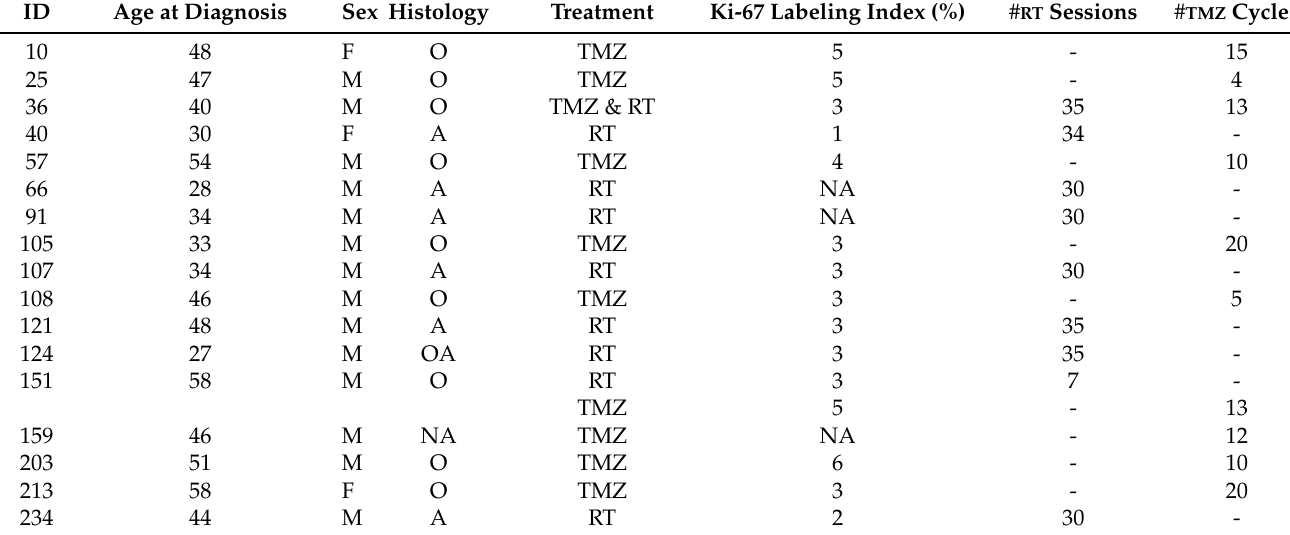
Table 1. Patients included in the study. Patient 36 was the only one treated with concurrent RT and TMZ. Patient 151 received RT and 11 years later TMZ. The meaning of the abbreviations used in the table can be found at the end of this